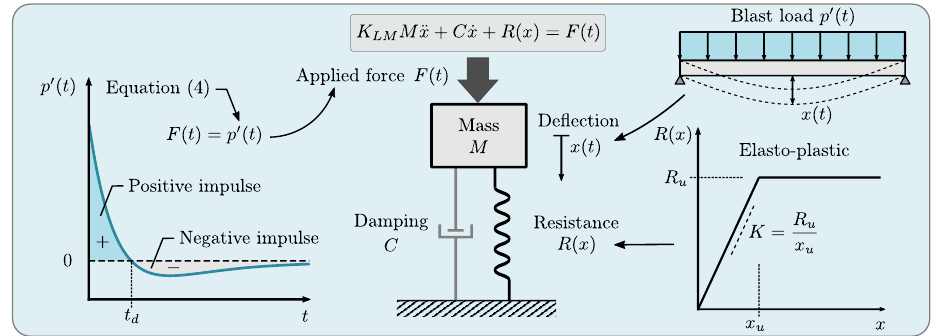
Figure 1. Sketch of the equivalent SDOF system showing the different terms involved in its mathe- matical description. Left : forcing term; right : resistance term; center : equivalent spring-mass SDOF system and its associated differential